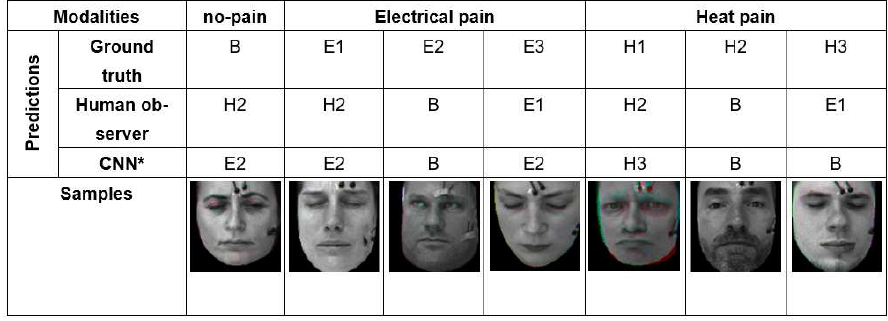
Figure 9. Some examples that the best model (CNN*) and human observer failed in classifying pain intensity and modality due to the difficulty of the